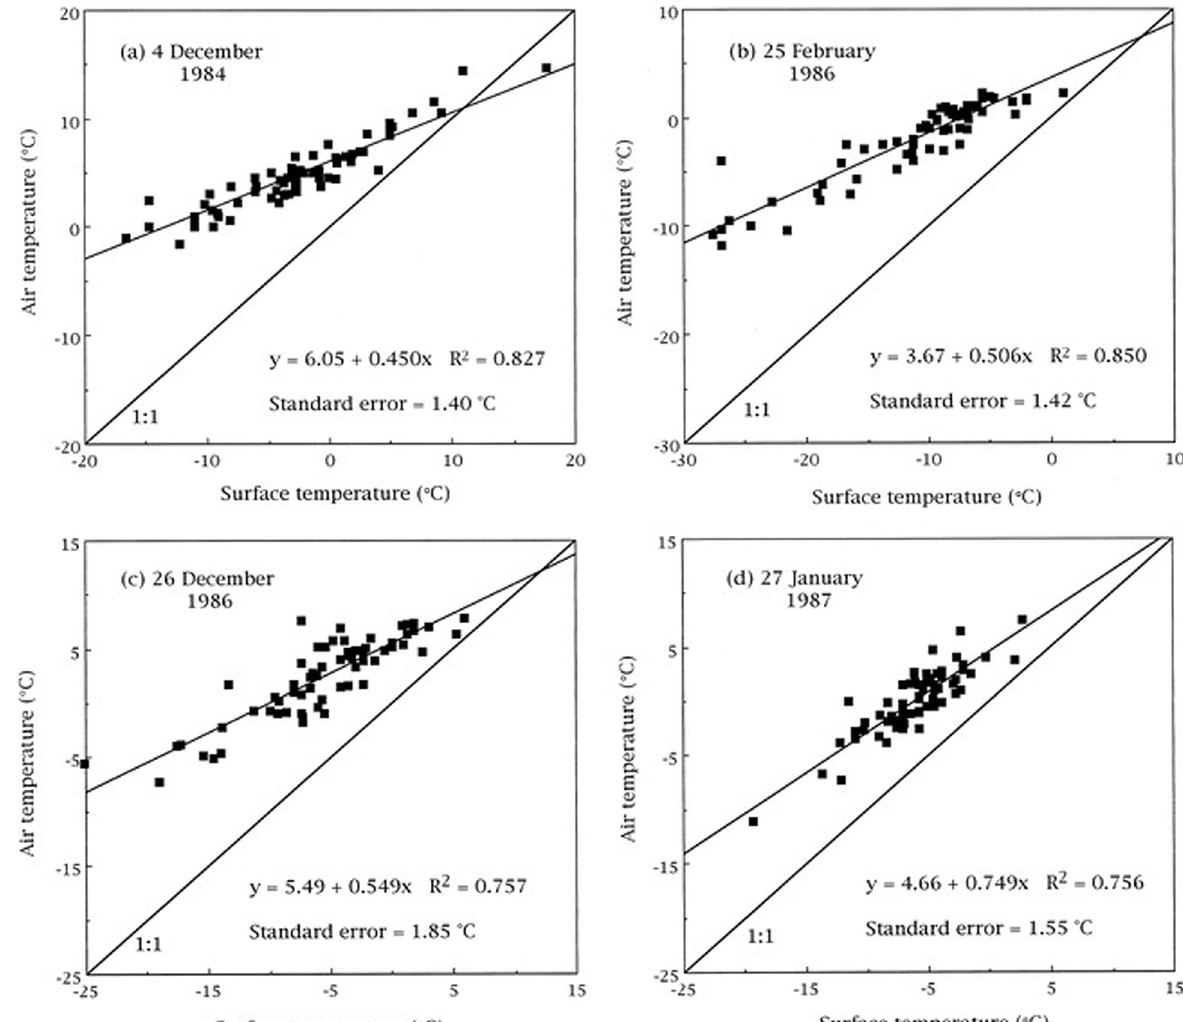
Fig. 9. Relations between surface temperature and air temperature on a local scale during winter nights (acc. to Kawashima et al. 2000).